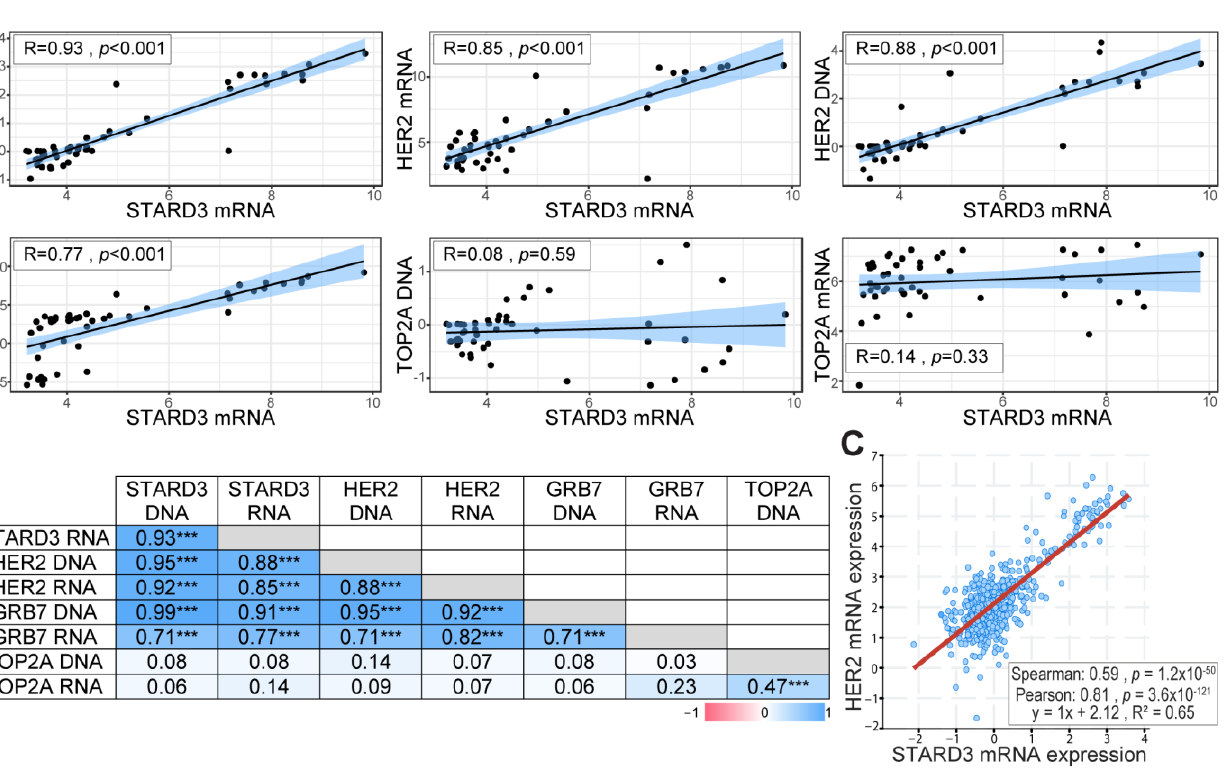
Figure 2. STARD3 and HER2 expression are correlated in breast cancers. ( A ) Pearson correlation coefficient and regression line showing the correlation between STARD3 DNA, HER2 RNA, HER2 DNA, GRB7 RNA, TOP2A DNA, TOP2A RNA, and STARD3 RNA. RNA and DNA data were obtained from the Cancer Cell Line Encyclopedia database. RNA expressions are Log2 values, DNA represents copy number variation. ( B ) Pearson correlation coefficient (r) matrix and its statistical significance (*** = p < 0.001) between STARD3, HER2, GRB7, TOP2A DNA, and RNA. STARD3 is correlated with HER2 and GRB7 but not with TOP2A. ( C ) Correlation between STARD3 and HER2 mRNA expression (microarray, log2 values) in a cohort of breast cancers from The Cancer Genome Atlas (TCGA) database (Cancer Genome Atlas Network, 2012).